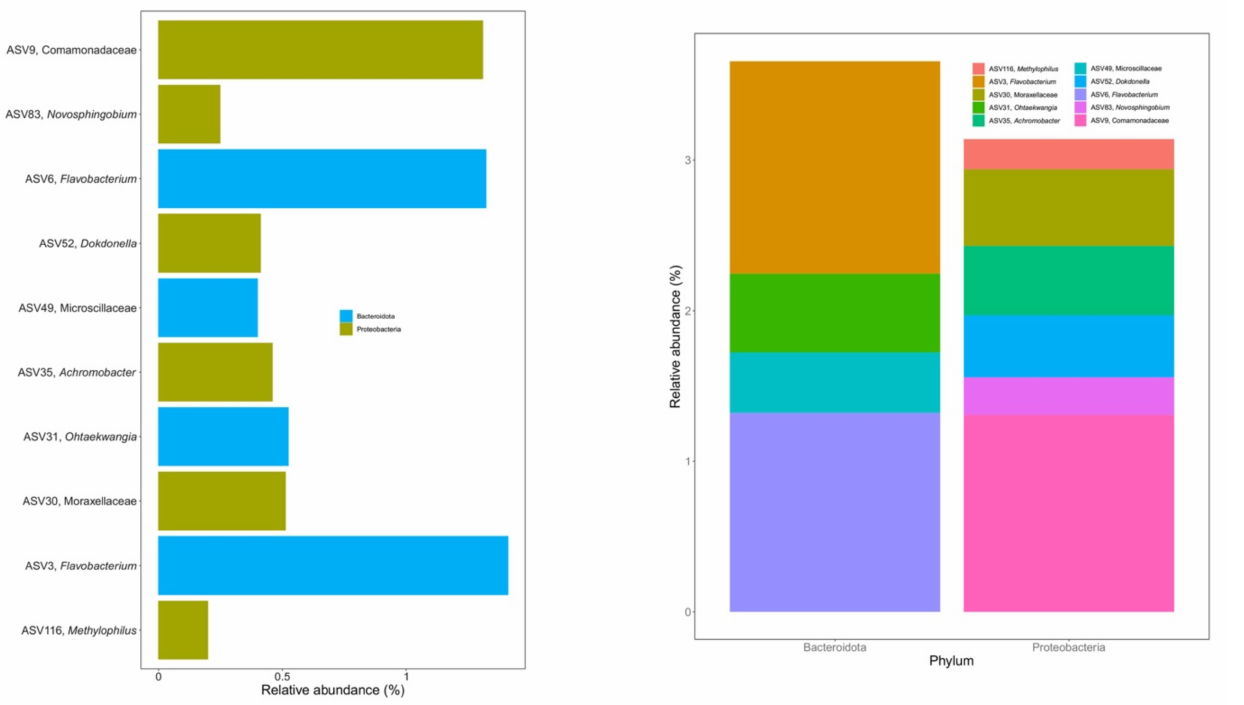
Figure 4. Core microbiome of the silver wattle vermicompost. Initial substrate (day 0) was not considered for determination of the core microbiome. The listed 10 ASVs represent 8.56% of sequences from days 14 to 56 and were found in all samples ( n =